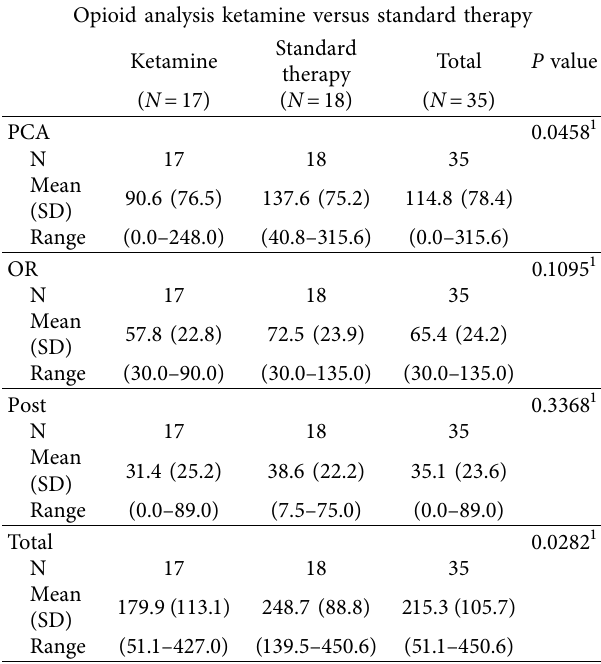
Table 3: Data on opioid consumption in oral morphine